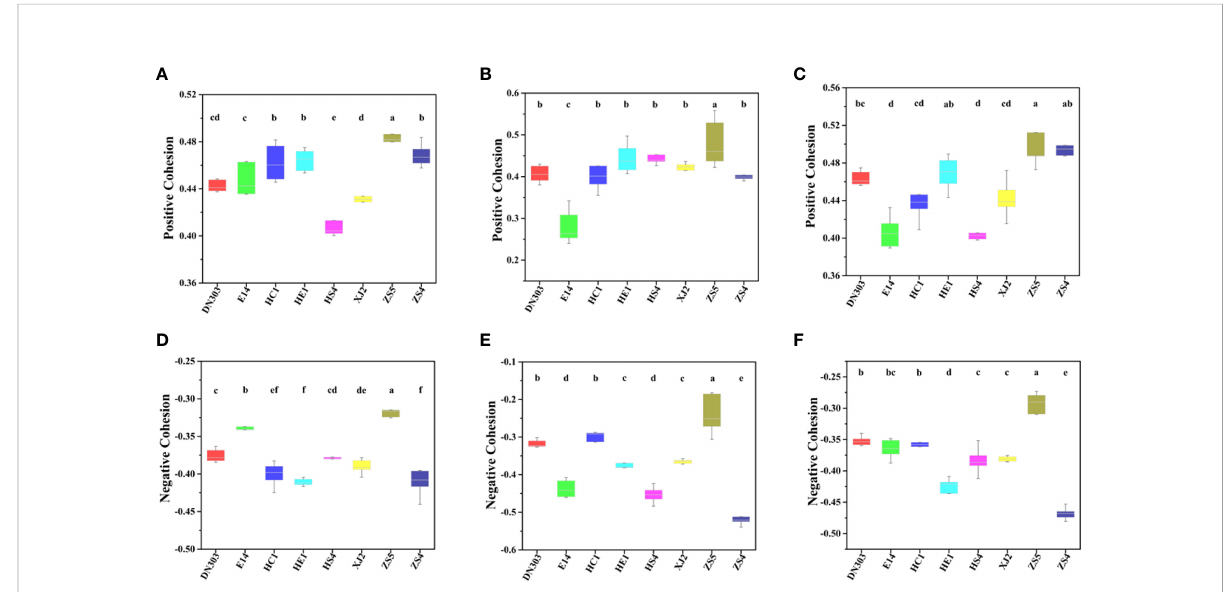
FIGURE 4 Difference in cohesion value of bacterial, fungal and bacterial-fungal communities among the eight potato cultivars. The difference was calculated by ANOVA analysis, the same letter indicates no difference ( P < 0.05). (A) The bacterial community positive cohesion, (B) the fungal community positive cohesion, (C) the bacteria-fungi community positive cohesion, (D) the bacterial negative cohesion, (E) the fungal negative cohesion, and (F) the bacteria-fungi community negative